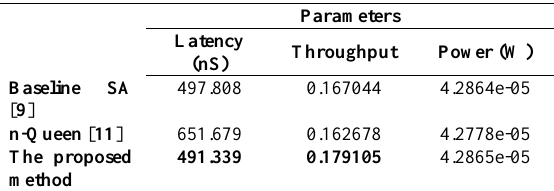
Table 2. Comparison of the proposed method with the related